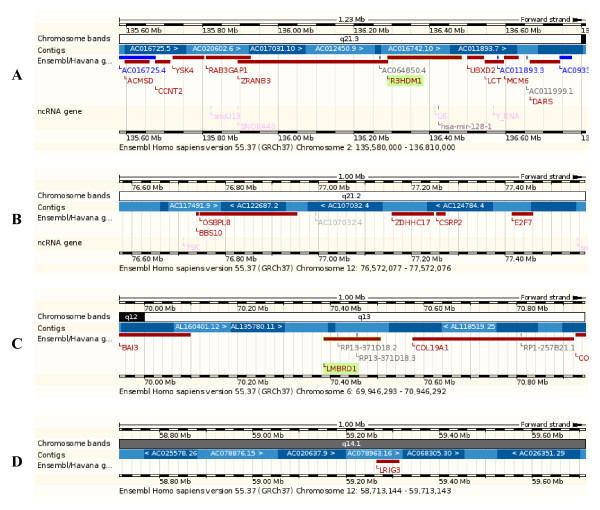
Gene regions associated with total cholesterol (TC). A) A 1.23 Mb region containing RAB3GAP1-R3HDM1-LCT-MCM6 with multiple SNP effects on TC. B) One Mb region containing OSBPL8-ZDHHC17 associated with HDL-C. C) One Mb region containing LMBRD1 that had multiple SNPs interacting with an SNP near LRIG3 for TC. D) One Mb region containing LRIG3 which was near an SNP interacting with multiple SNPs in LMBRD1 for TC.